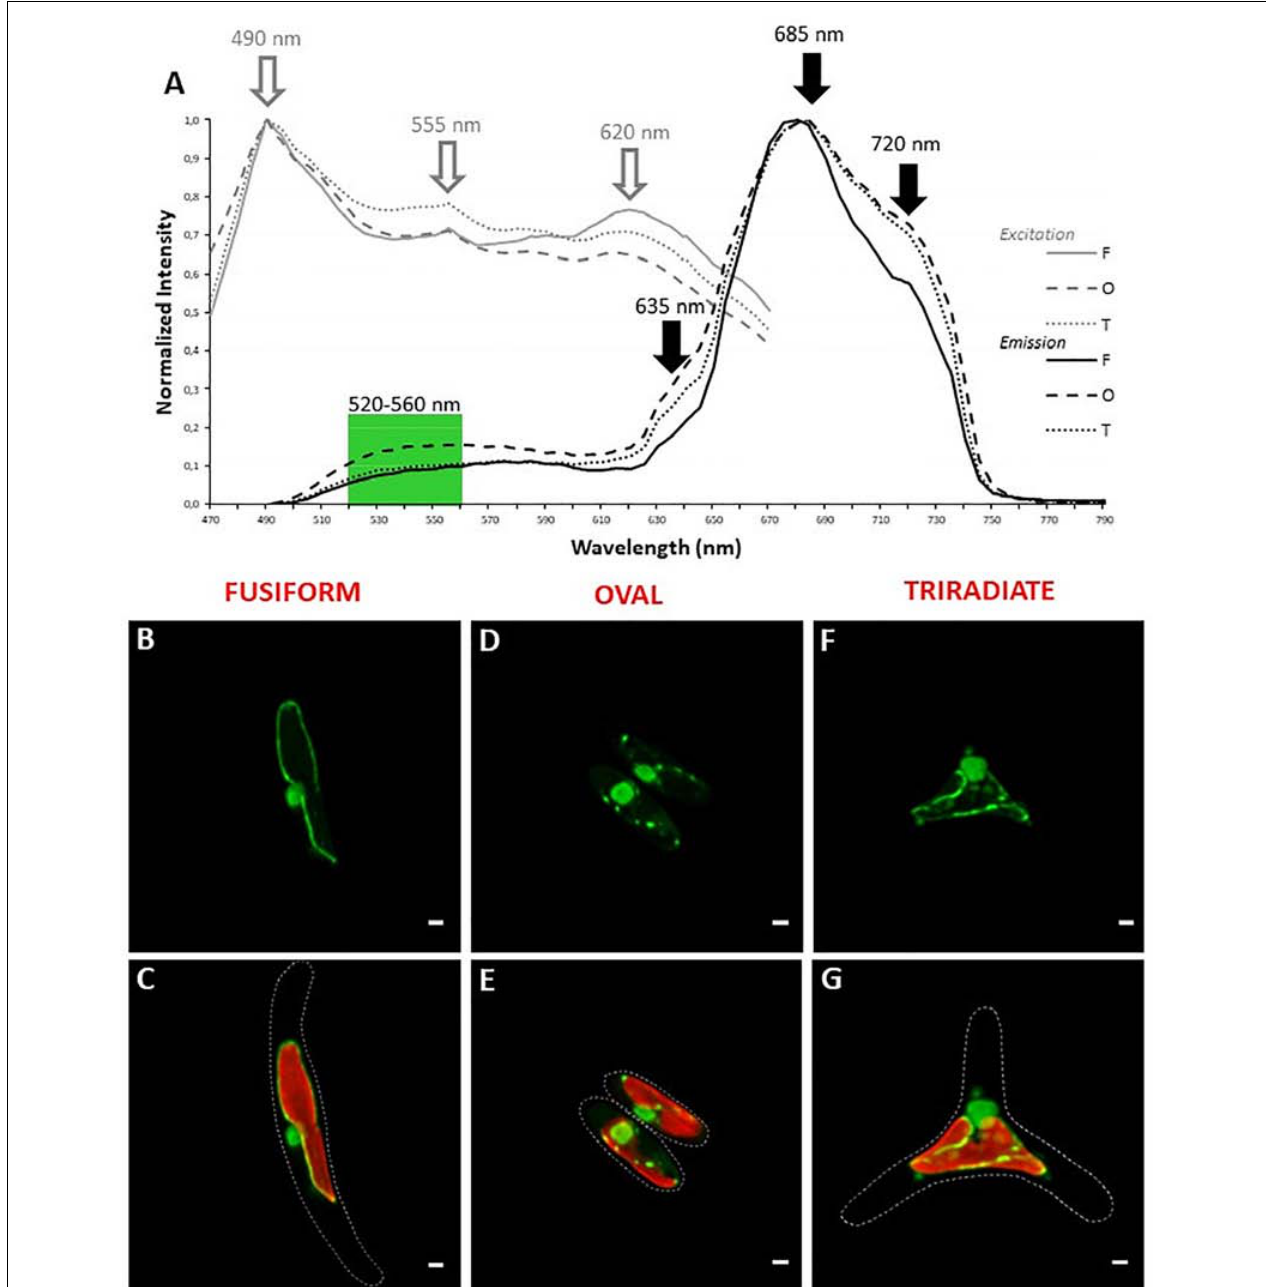
FIGURE 3 | Localization of nucleic acids in living P. tricornum Pt3 morphotypes. (A) Spectral characterization ( (cid:51) λ -scan microscopy) for single excitation and double emission settings in Syto 21-labeled and autofluorescent choloroplast-containing cells ( n = 20). Excitation spectra are represented by gray lines. Emission spectra are represented by black lines. Dashed lines: oval cells; solid lines, fusiform cells; dotted lines: triradiate cells. (B,D,F) Localization of DNA/RNA in Pt3 morphotypes after staining with Syto 21. (C,E,G) Combination of Syto 21 images with plastid autofluorescence. Bars, 1 µ